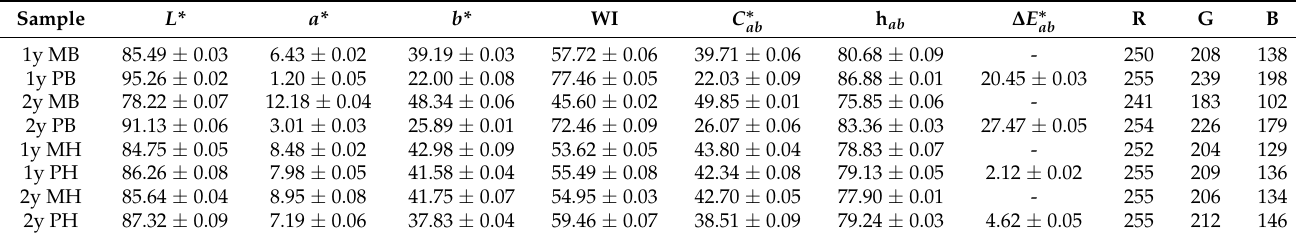
Table 5. Plasma effect on color parameters: CIE L * a * b *, WI, chroma, angle hue and ∆ E ∗ must) of white wine and the corresponding R G B coordinates (using equation system (1) and [83]), for 1 and 2 years old wine (mean ± standard